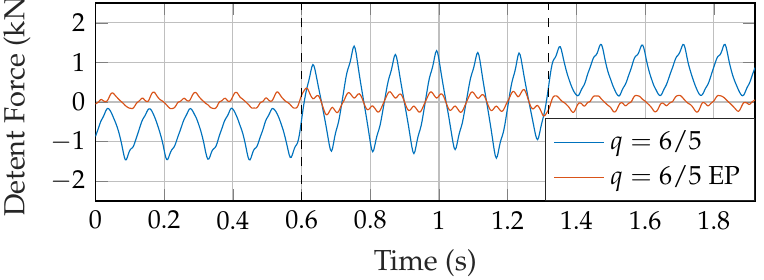
Figure 8. Detent forces for q = 1 with end plates (EP). Full active stator area is from t = 0.6 s to t = 1.32 s, indicated by the dashed vertical lines.